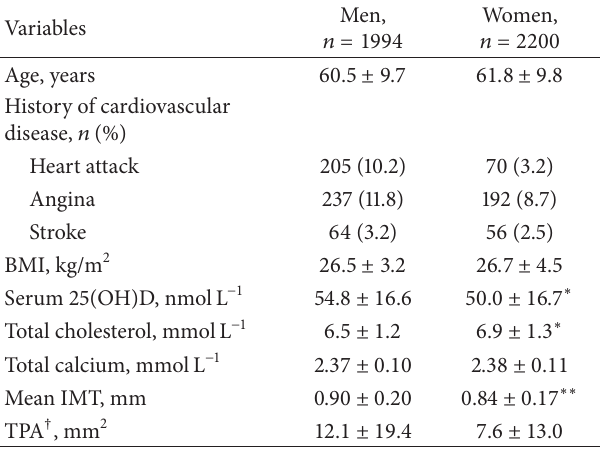
Table 1: Characteristics of the study population. The 4th Tromsø Study, 1994-1995. Variables